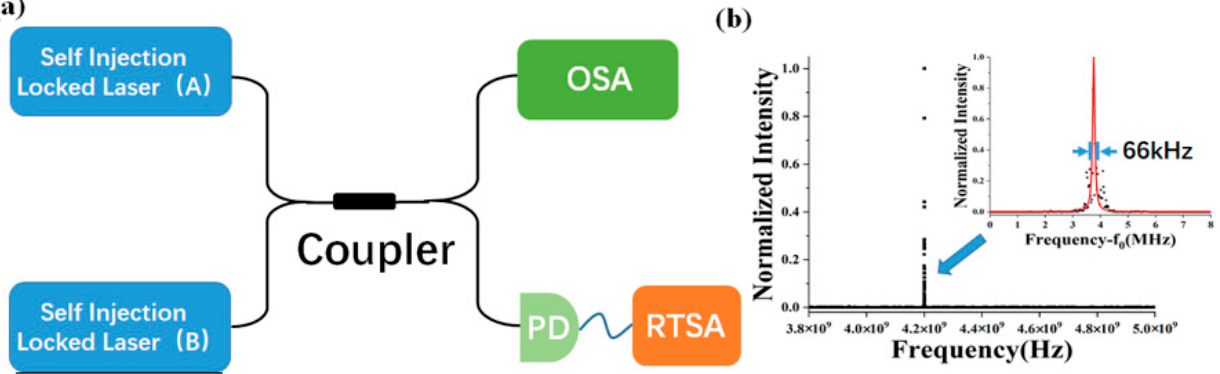
Figure 4. ( a ) Setup for the heterodyne measurement. OSA: optical spectrum analyzer; PD: photodetector; RTSA: real-time spectrum analyzer. ( b ) Beating signal measured in optical heterodyne measurement. The black dots are measured data, and the red curve is its Lorentz fitting. In the zoom-in fi gure, f 0 = 4.197 GHz.